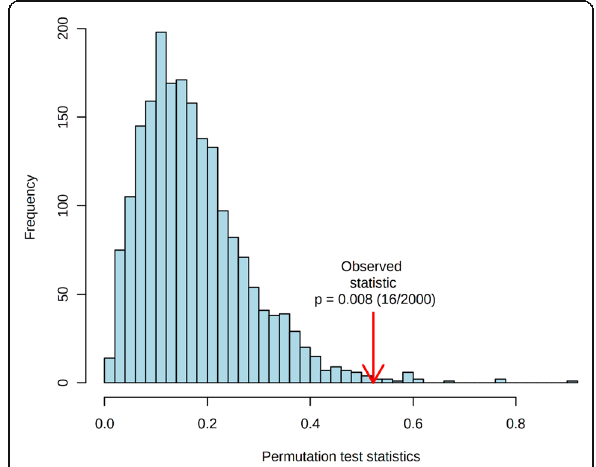
Fig. 10 Permutation test to validate PLS-DA. It showed p value to be 0.008